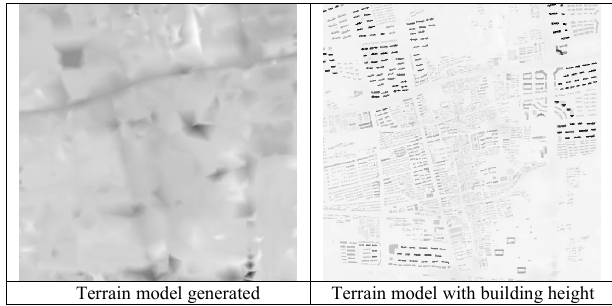
Table 1 . The terrain model of Xinchang Ancient Town